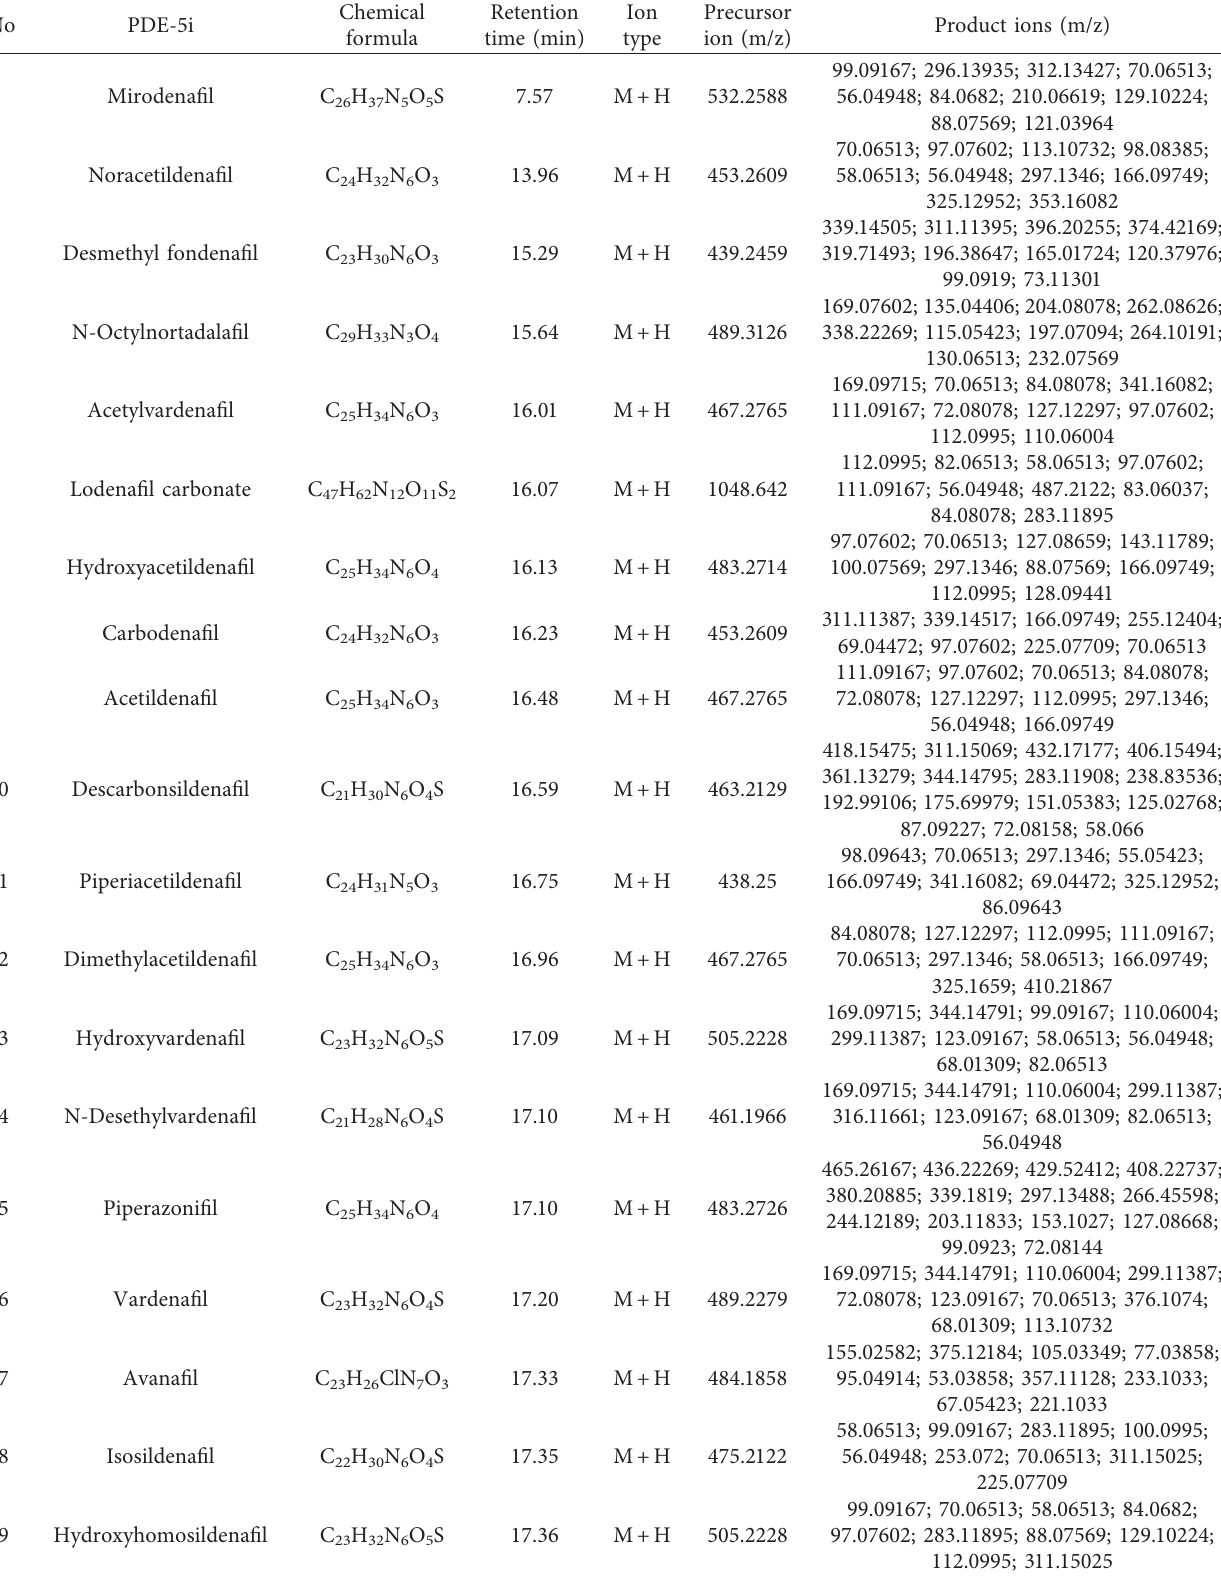
Table 1: Mass spectrometric parameters for identification and retention time of